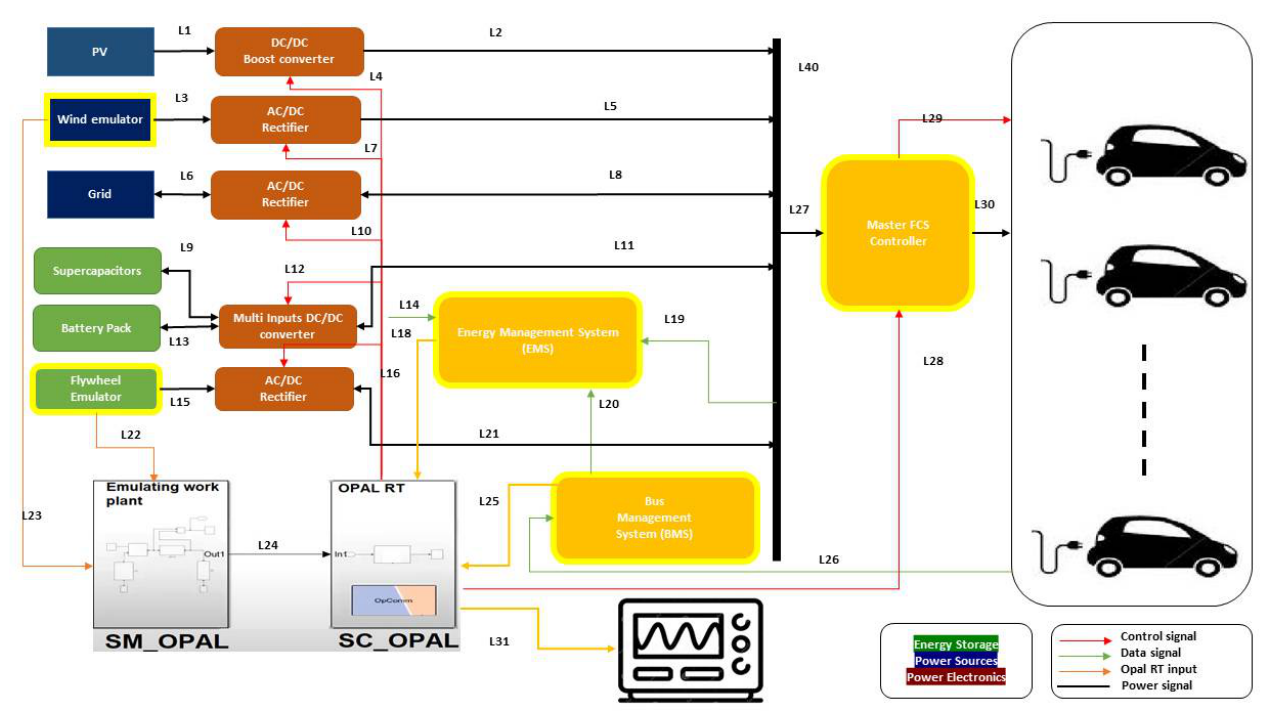
Figure 1. Microgrid structure.